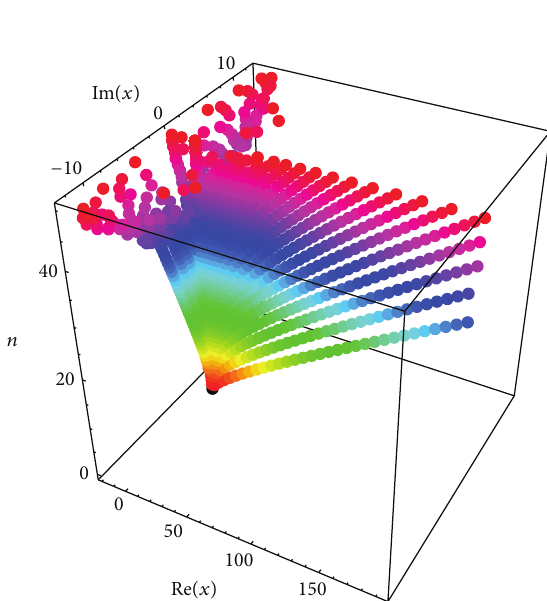
̃𝑈 (𝑥) for 1 ≤ 𝑛 ≤ 50 . 𝑛